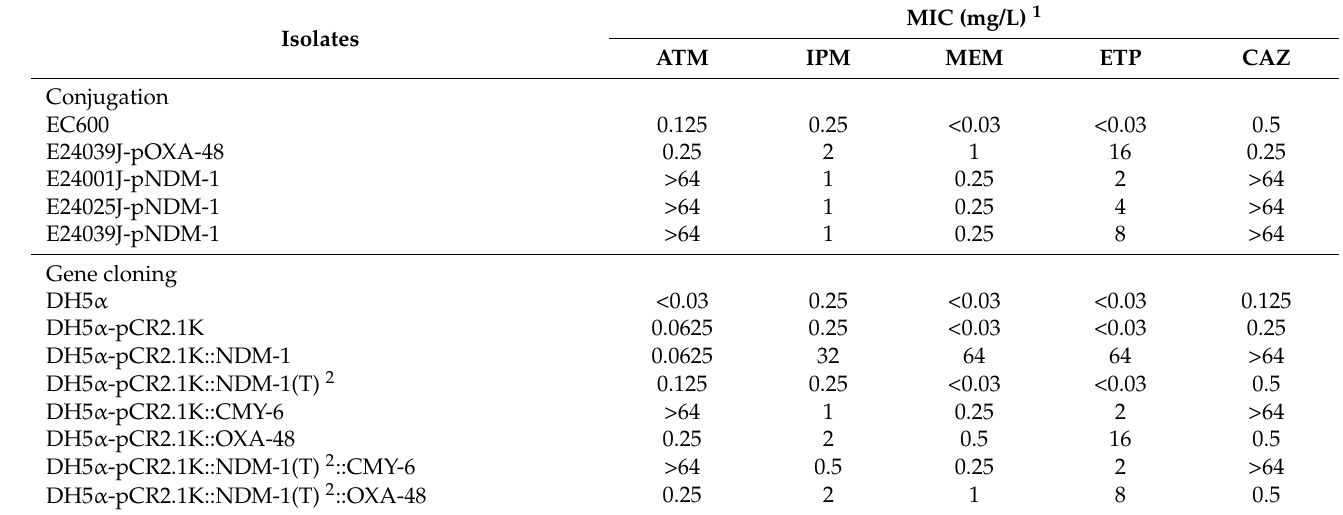
Table 2. Antimicrobial susceptibility of conjugates and the gene cloning isolates.